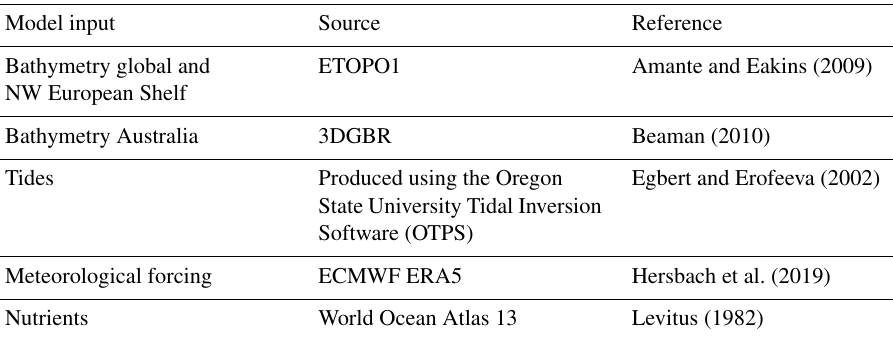
Figure 3. Overview of the S2P3-R v2.0 framework, which includes the model and runscript but also separate scripts to generate the required input files. The arrows show where externally available data or the output from one component of S2P3-R V2.0 is supplied to another component or output. Table 1. Model